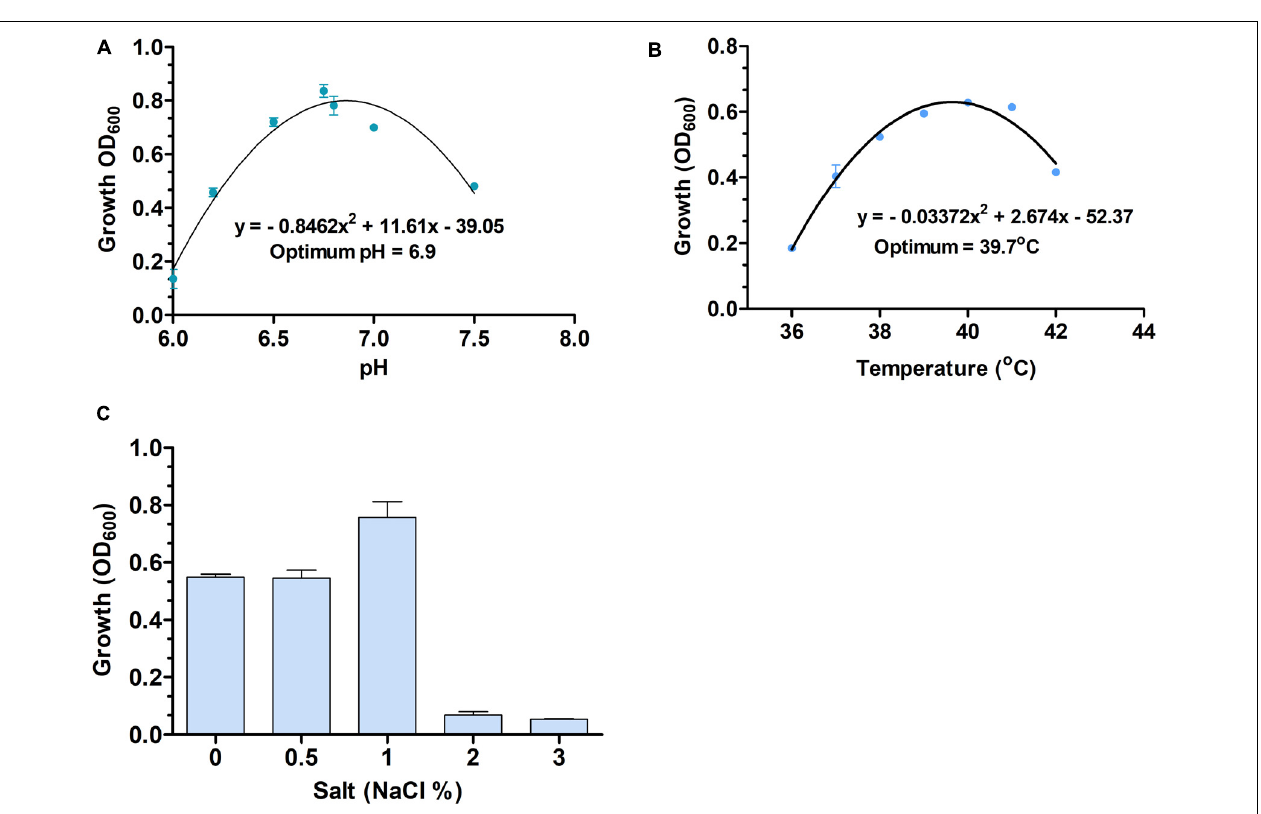
FIGURE 5 | The optimum temperature and pH (A,B) , and different salt (% NaCl) concentrations (C) used for Succinivibrio dextrinosolvens strain Z6 growth. Data points represent averages from triplicate experiments. Error bars represent standard